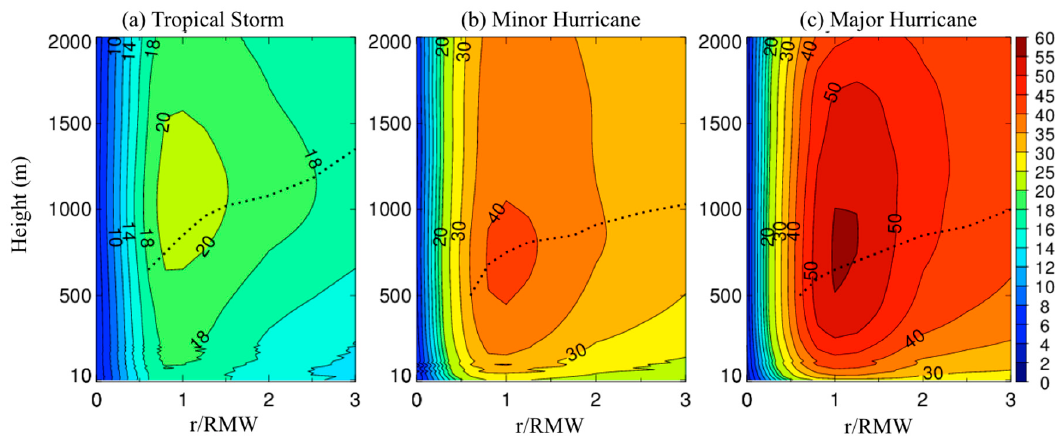
Figure 3. Composite analysis of the tangential velocities (m s − 1 ) as a function of altitude and normalized radius for ( a ) tropical storms, ( b ) minor hurricanes, and ( c ) major hurricanes. The dashed line in each panel depict the height of the maximum wind velocity as it varies with radius. The contour intervals in ( a ), ( b ), and ( c ) are 2, 5, and 5 m s − 1 , respectively.